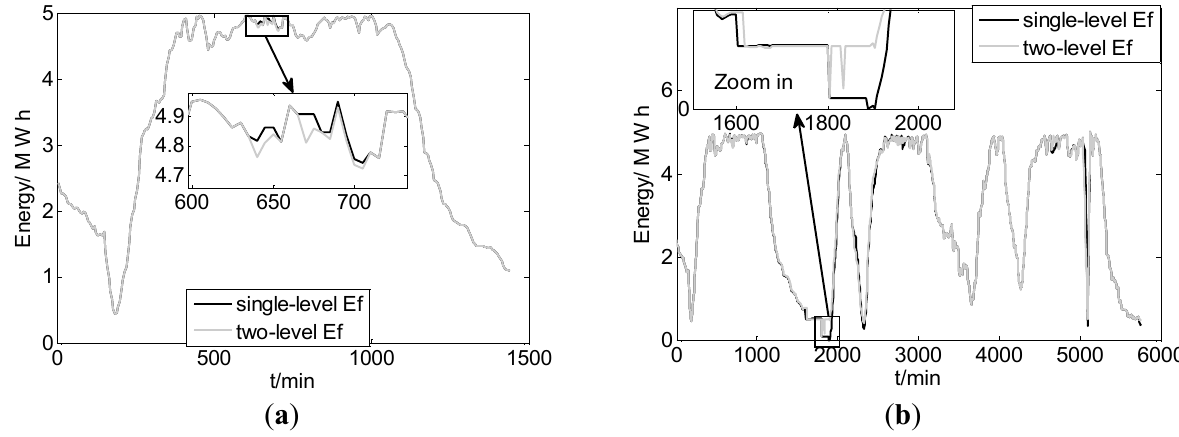
Figure 16. Operating states of the fly wheel. ( a ) One day operating states of fly wheel; ( b ) Four days operating states of fly